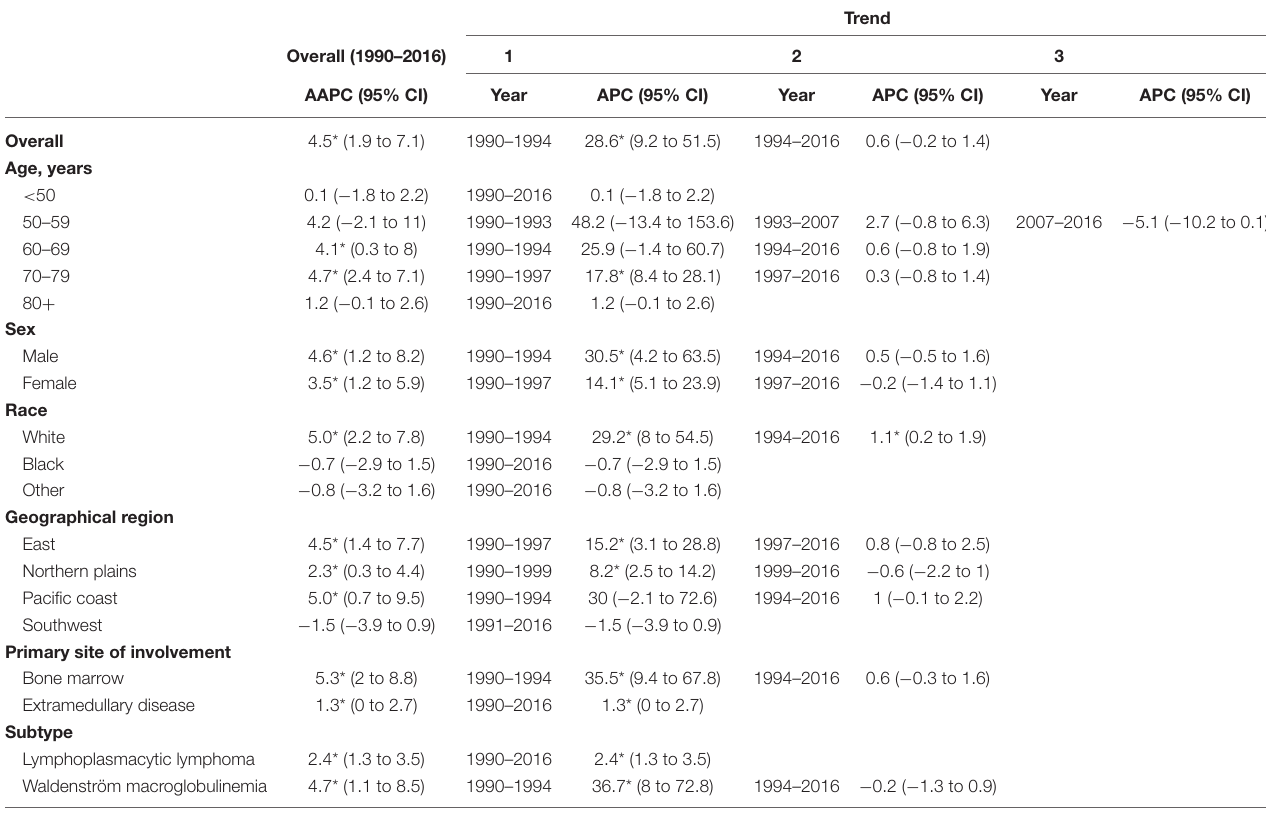
TABLE 3 | Trends in the incidence-based mortality rates of Waldenström Macroglobulinemia (1990–2016): The SEER-9 Registry